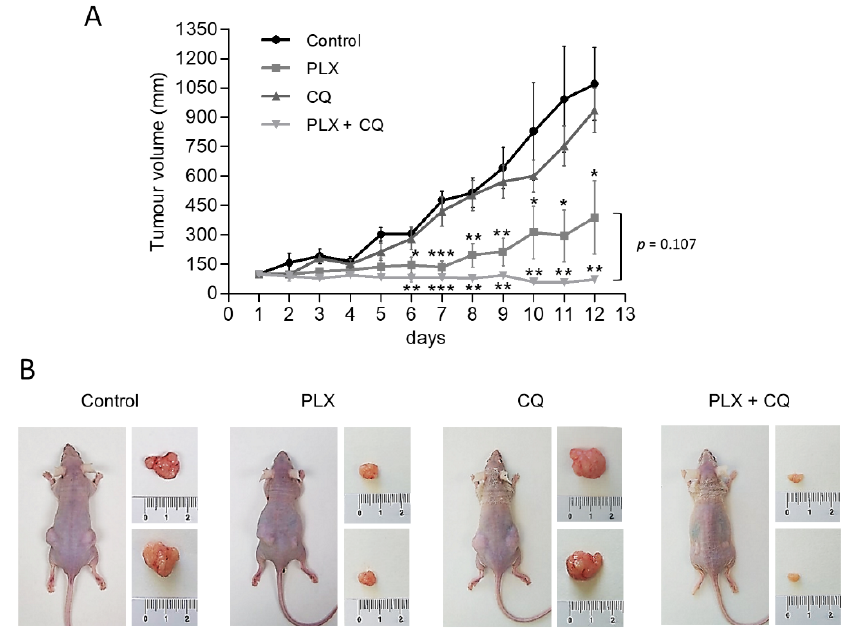
Figure 5. Autophagy inhibition enhances antitumor activity of PLX4720 BRAFi in vivo. Mice bearing subcutaneous BHT101 cells-derived xenografts on both flanks were randomly divided into four groups and treated intraperitoneal with vehicle (control), 25 mg/kg/day PLX4720 (PLX), 60 mg/kg Chloroquine (CQ) or combination of both (PLX + CQ) for 12 days. ( A ) Curves of tumour growth monitored by measuring the tumour volumes over time after the treatments. Data are shown as the mean ± SEM; n = 6. ( B ) Representative images showing mice from different treatment groups with tumours on day 12 of treatment. Significant differences compared to the corresponding untreated control: * 0.01 < p < 0.05, ** 0.001 < p < 0.01, *** p < 0.001.